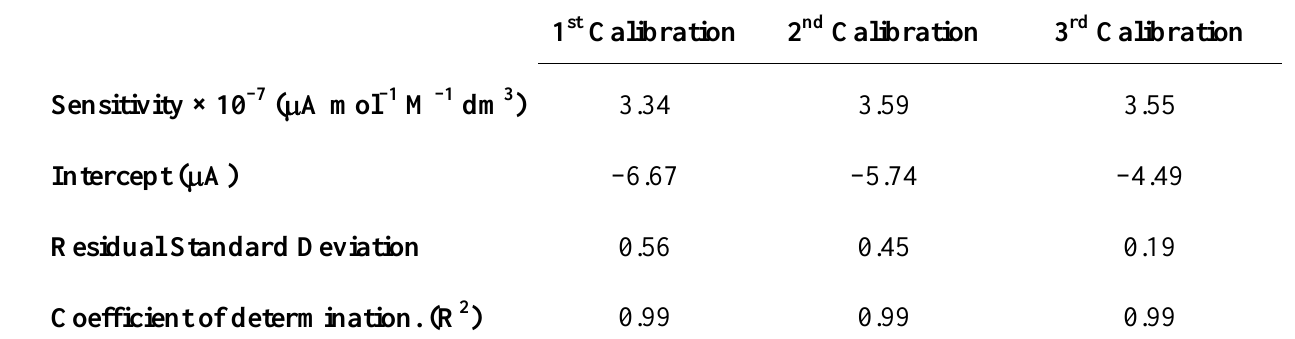
Table 3. Calibration parameters obtained for electrode repeatability